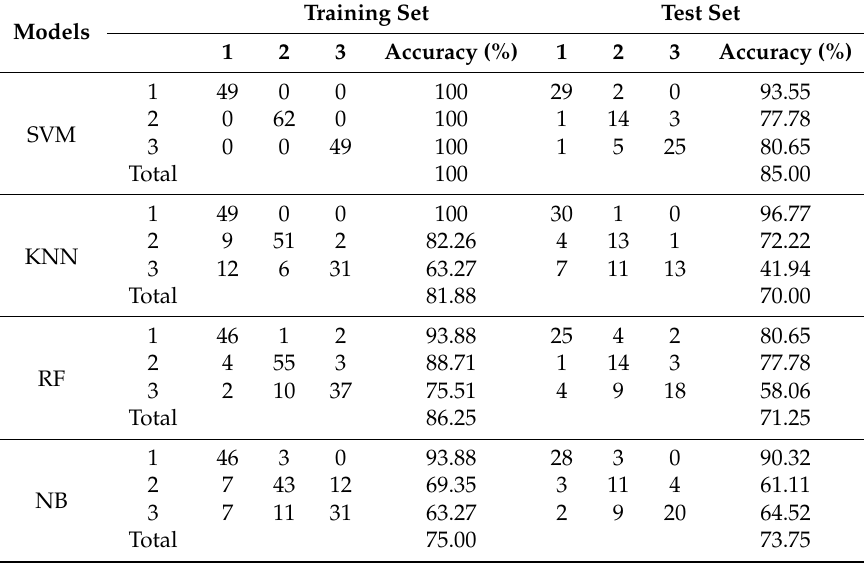
Table 2. The confusion matrices of the training set and test set in SVM, KNN, RF and NB models. Training Models